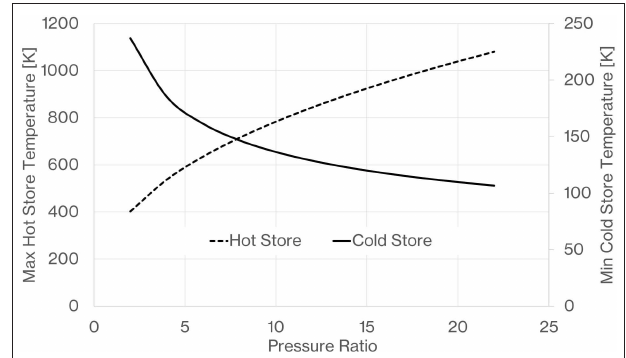
FIGURE 19 | Turn-round efficiency as a function of compressor and expander isentropic efficiencies.